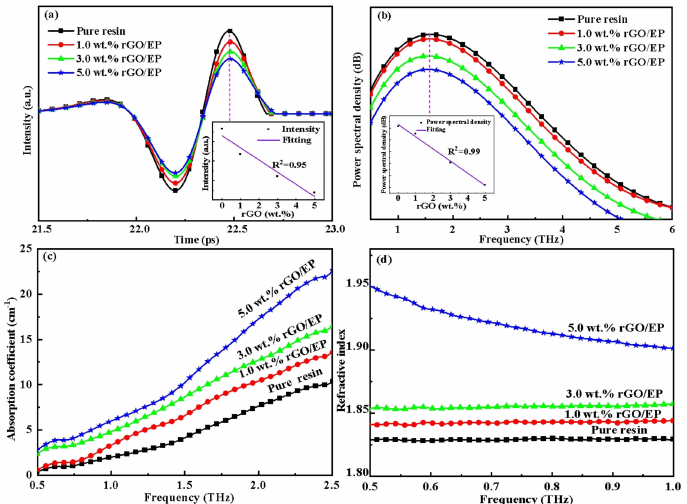
Figure 4. Terahertz spectral characterization of rGO/EP coatings: ( a ) time domain, ( b ) frequency domain, ( c ) absorption coefficient, ( d ) refractive